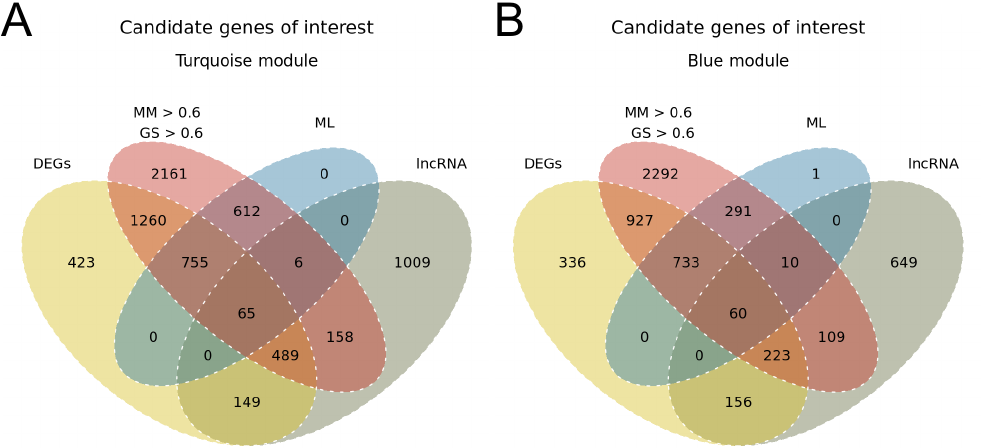
Figure 4. Venn diagram illustrating the number of genes selected by different approaches: DEGs, MM and GS > 0.6, ML, and filtering for lncRNA biotype. ( A ) All genes from the turquoise module. ( B ) All genes from the blue